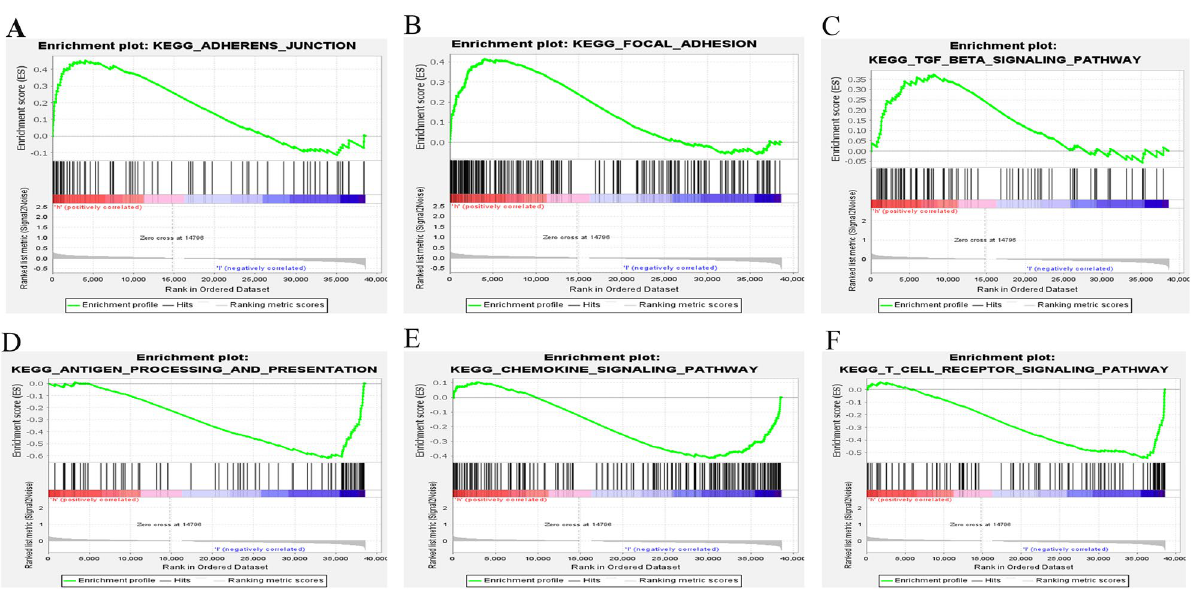
Figure 5. Gene set enrichment analysis (GSEA) of high-risk group and low-risk group based on the necroptosis-related lncRNAs prognostic signature. ( A – C ) GSEA results show significant enrichment of adherens junction, focal adhesion, and TGF beta signaling pathway in the high-risk CESC patients. ( D – F ) GSEA results show significant enrichment of antigen processing and presentation, Chemokine signaling pathway and T cell receptor signaling pathway in the low-risk CESC